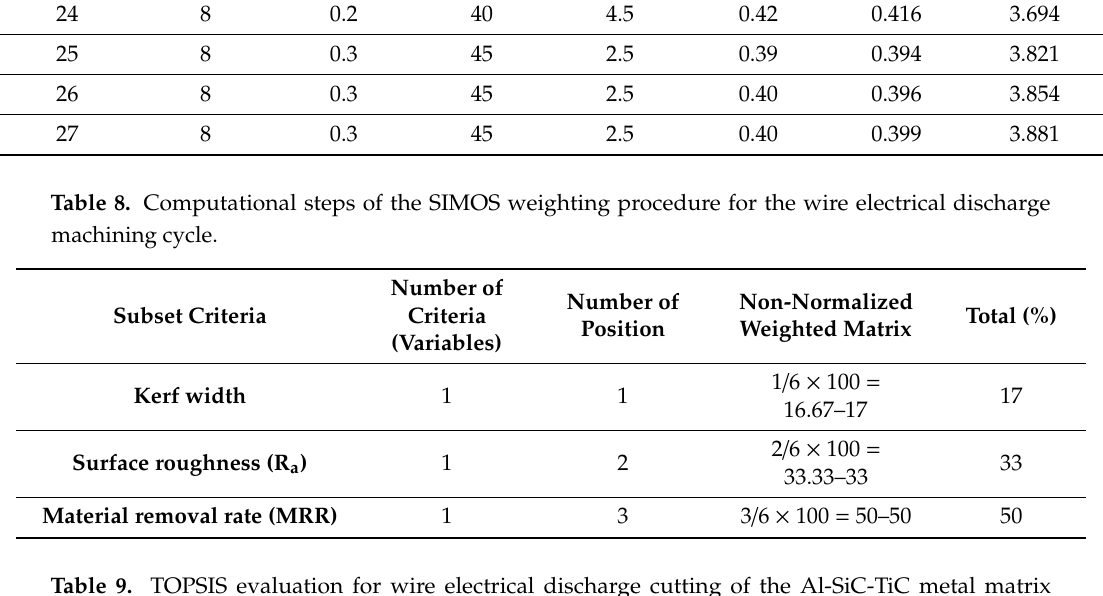
Table 9. TOPSIS evaluation for wire electrical discharge cutting of the Al-SiC-TiC metal matrix composite under a deionized dielectric